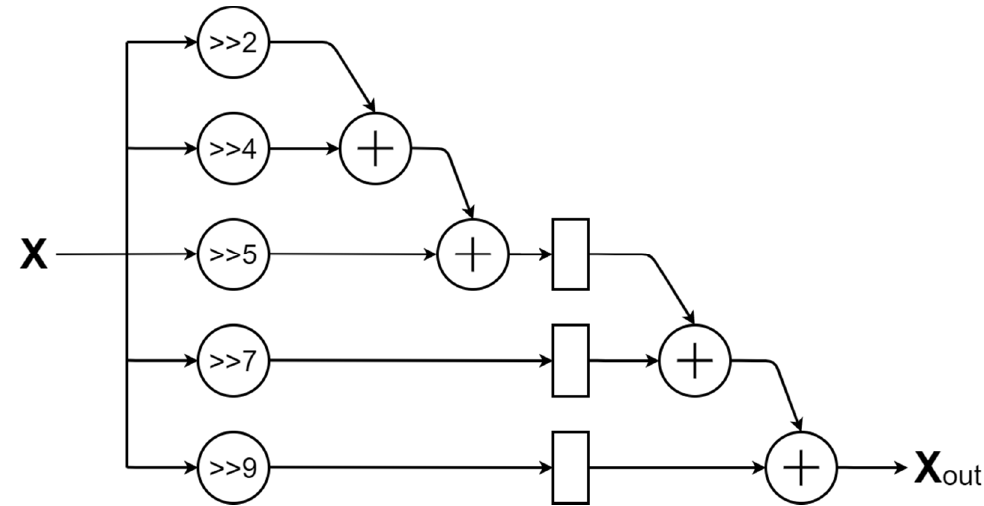
Figure 7. The architecture of the hardware-sharing machine with scale factor_1.